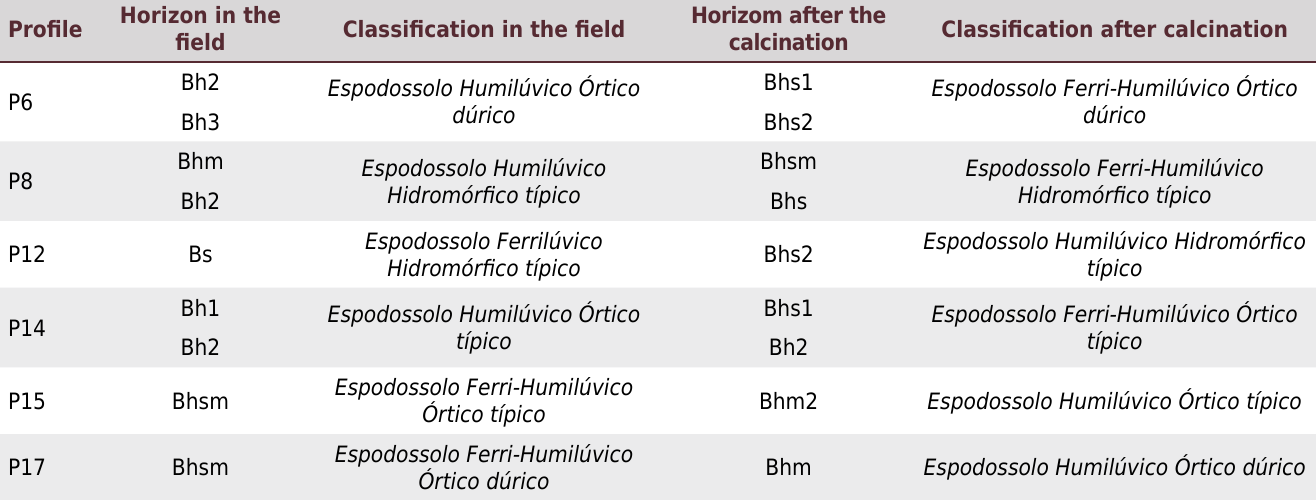
Table 3. Classification of profiles before (morphological description in the field) and after application of the calcination procedure Horizon in Profile